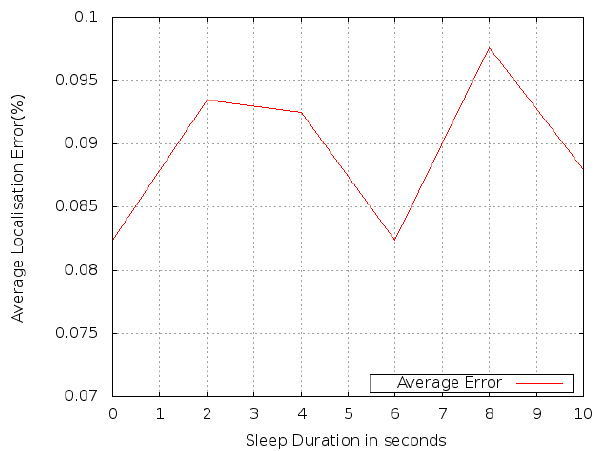
Figure 20. Average localization error variation with change in sleep